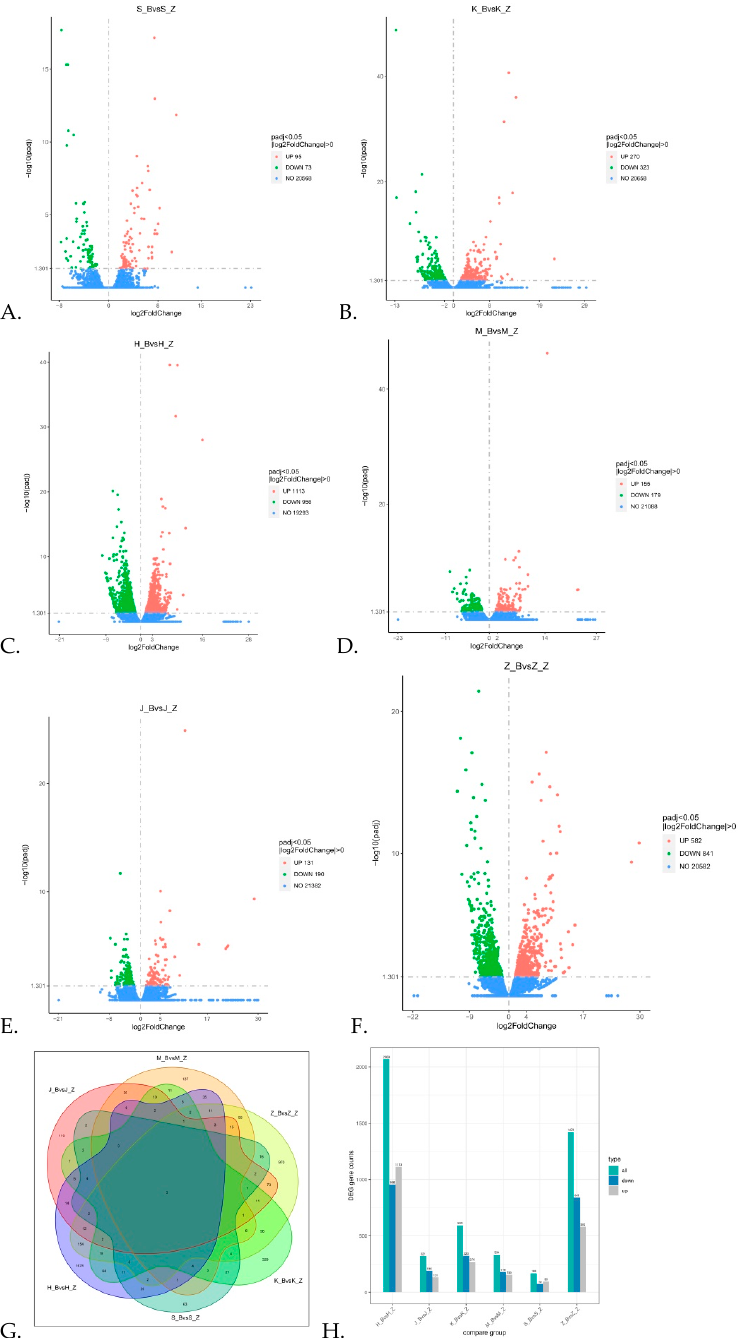
Figure 3. Differential gene volcano map, differential gene Wayne map, and differential gene number histogram. ( A – F ) The Vocalo diagram analysis of DEGs in the duodenum, jejunum, ileum, cecum, colon, and rectum in turn. Red indicates significantly upregulated DEG, and blue indicates sig- nificantly downregulated DEG (|log2(foldchange)| > 1 and p -value ≤ 0.05). ( G ) Differential gene Venn diagram; different colors indicate different comparison combinations. ( H ) The histogram of the number of differentially expressed genes is shown in blue and gray. The number on the column represents the number of differentially expressed genes. S_Z: the duodenum of healthy rabbits, S_B: diarrhea in the duodenum of rabbits, H_Z: healthy rabbit ileum, H_B: diarrheal rabbit ileum, K_Z: healthy rabbit jejunum, K_B: rabbits with diarrheal jejunum, M_Z: healthy cecum of rabbits, M_B: rabbits with diarrheal cecum, J_Z: healthy rabbit colon, J_B: colon of rabbits with diarrhea, Z_Z: healthy rabbit rectum, Z_B: rectum of rabbits with